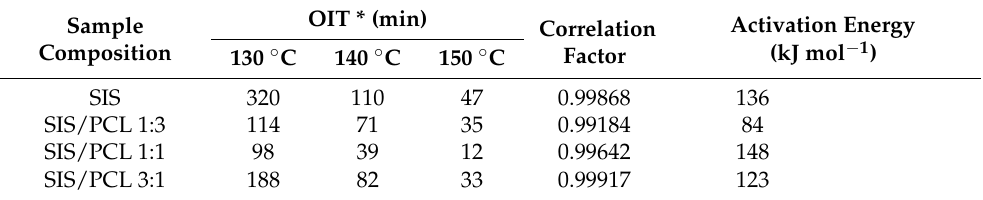
Table 1. The activation energies for thermal degradation of SIS/PCL systems from their OIT values. Sample